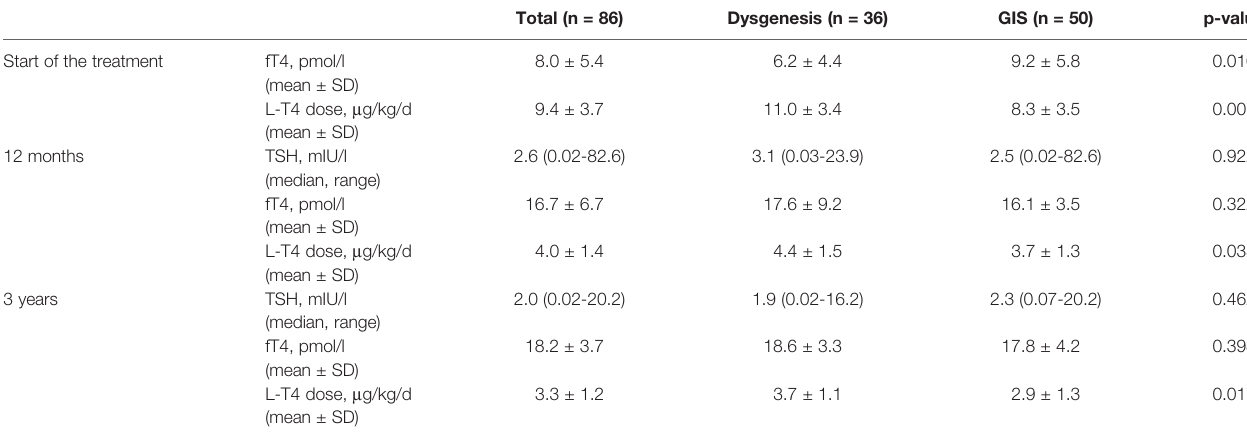
TABLE 4 | Levothyroxine treatment and thyroid ultrasonography evaluation.